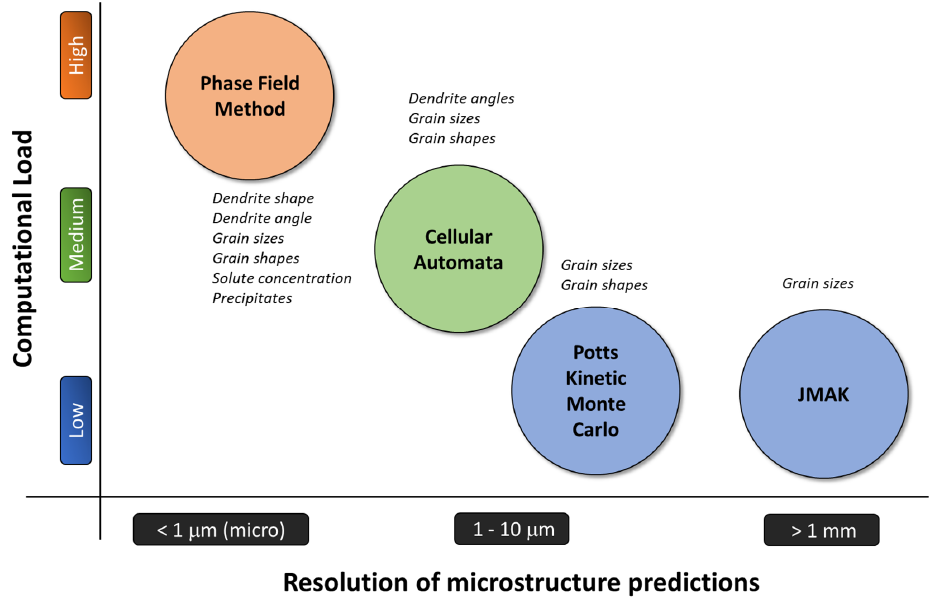
Figure 5. Resolution of microstructures obtained from different techniques vs. computational load involved. Note that the axes are not drawn to scale. (Information for this figure was drawn from [19]).